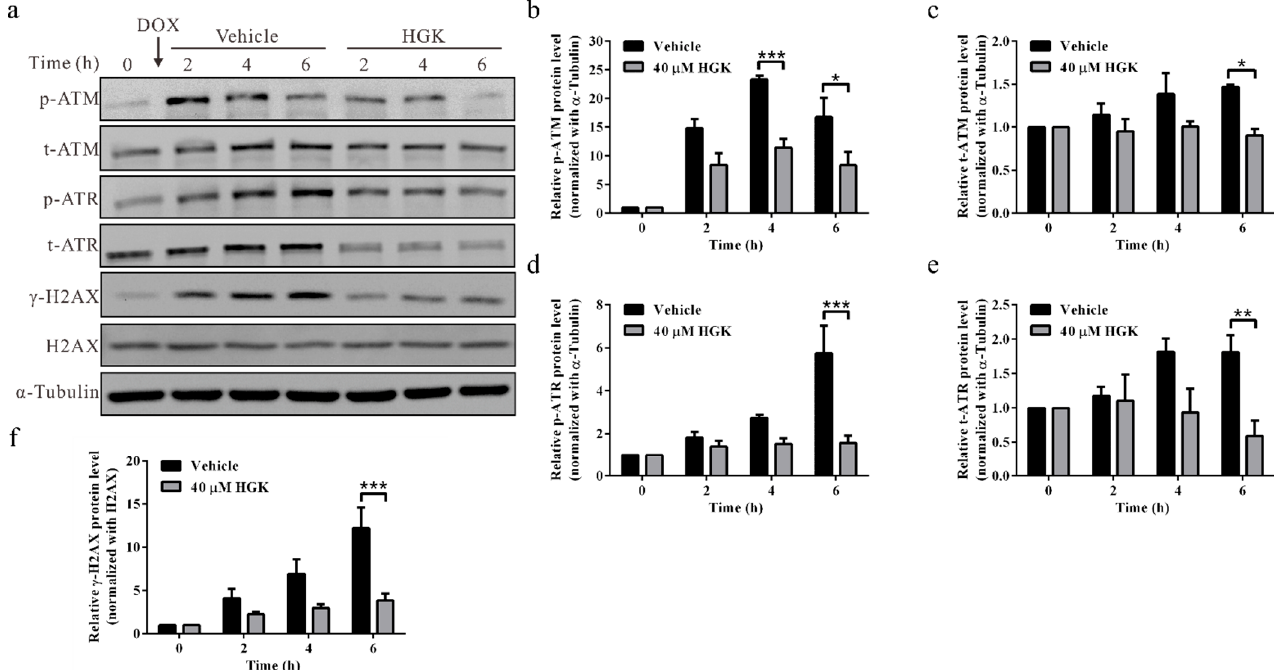
Figure 5. Hydroxygenkwanin (HGK) inhibits the activation of DNA damage checkpoint proteins, ataxia telangiectasia- mutated (ATM) and ataxia telangiectasia- and Rad3-related (ATR). ( a ) Huh7 cells were treated with 0.5 µ M doxorubicin for 1 h, followed by treatment with 40 µ M HGK in doxorubicin-free medium. Cells were harvested at indicated time points, and the activation of ATM and ATR was analyzed by Western blotting. α -tubulin served as an internal control. ( b – f ) Quantitative results for ATM and ATR activation. All experiments were performed in triplicate. p-ATM/ATR: phosphorylated ATM/ATR; t-ATM/ATR: total ATM/ATR. p < 0.05 (*), p < 0.01 (**), p < 0.001 (***).